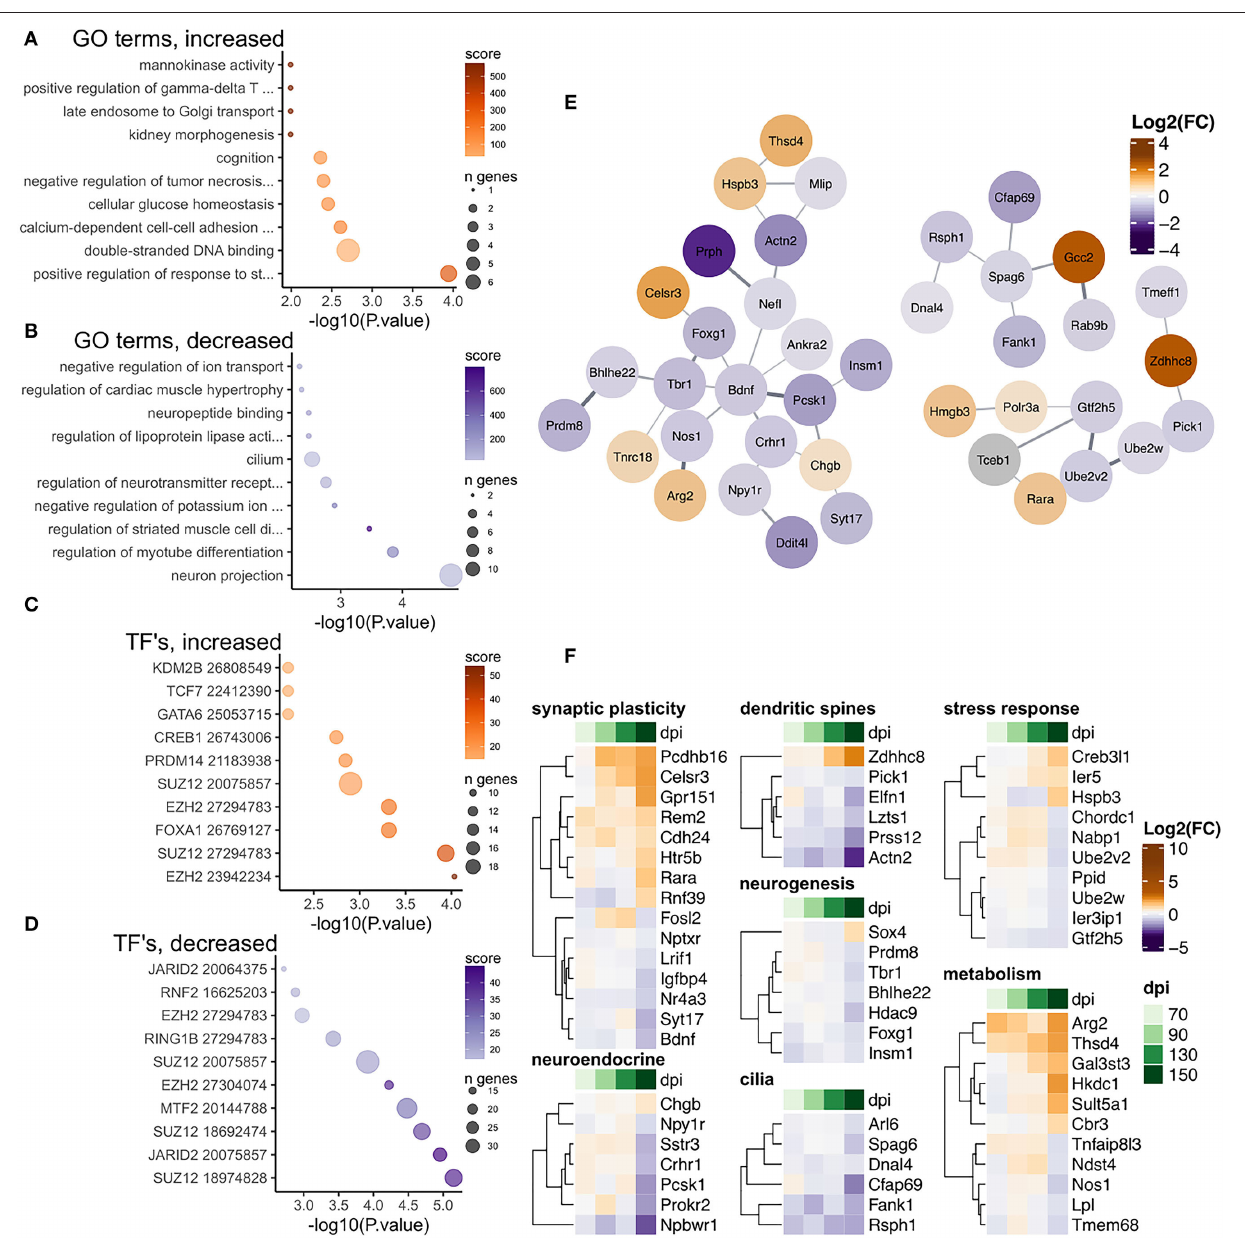
FIGURE 5 | Transcriptional changes affiliated with CA1 neurons in RML infected mice at 150 dpi. Enrichr was used to identify enriched gene ontologies for CA1 neuron affiliated transcripts that were (A) increased and (B) decreased during RML disease. Enriched transcription factors were also identified for (C) increased and (D) decreased transcripts. (E) STRING was used to construct a protein-protein interaction network of all 123 prion altered CA1 neuron transcripts. (F) Heatmaps were used to visualize magnitude of change, expressed as log 2 fold-changes at each timepoint for notable CA1 neuron transcripts that were categorized as related to synaptic plasticity, the neuroendocrine system, dendritic spines, neurogenesis, cilia, stress response, and